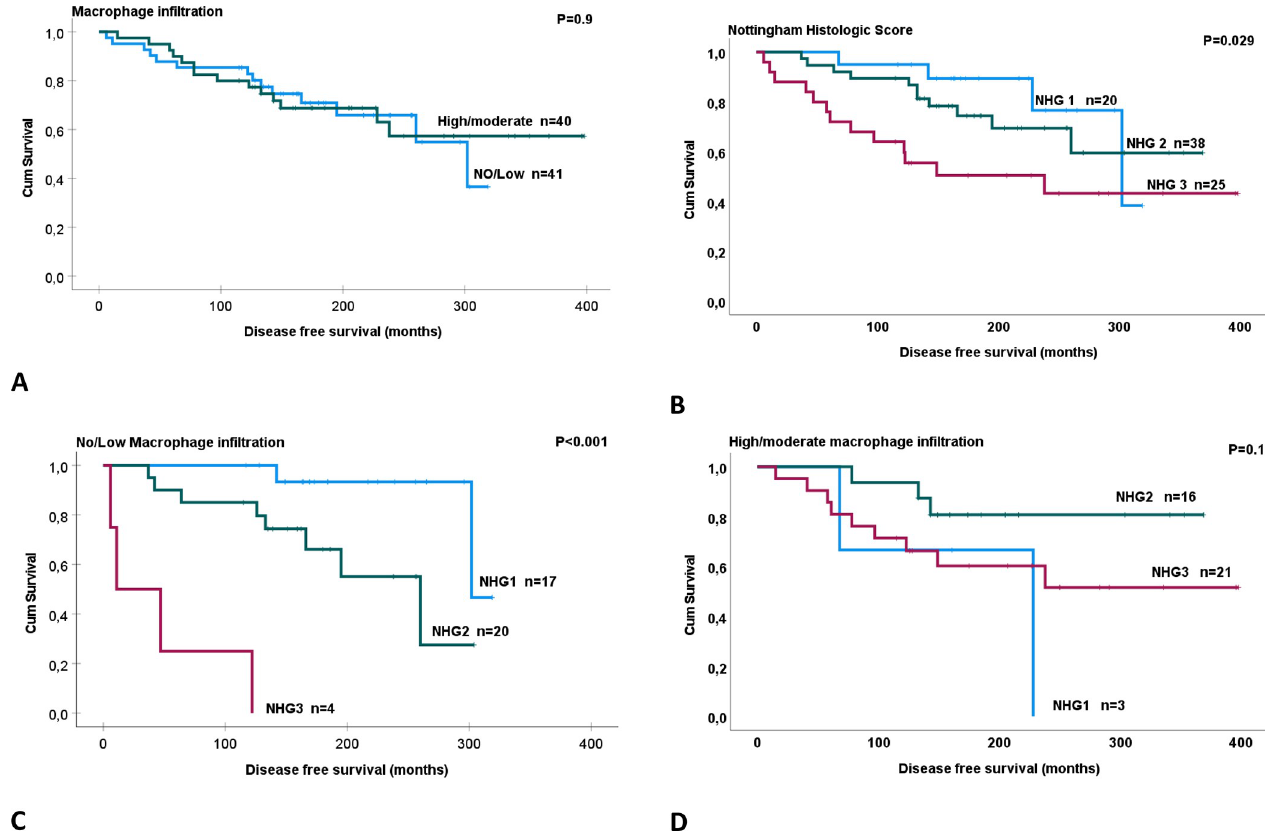
Fig 5. Kaplan-Meier curves demonstrating disease-free survival (DFS) in relation to (A) Nottingham Histologic Grade (NHG) and (B) macrophage infiltration for 83 patients with non-metastasized pT1-pT2 breast cancers treated with breast conserving surgery. In subgroup analysis, panels C and D show DFS in relation to NHG in patients having tumors with No/low and High/moderate macrophage infiltration, respectively. The comparison in this survival analysis is estimated according to the log-rank (Mantel-Cox) test.